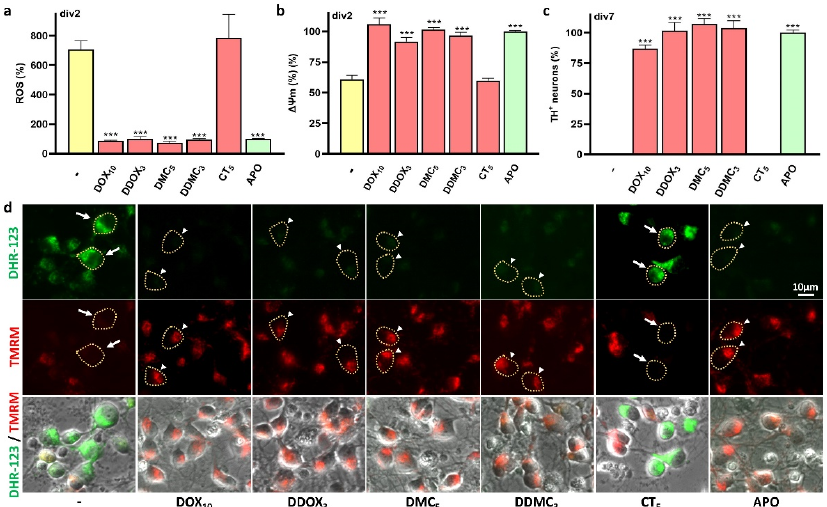
Figure 7. DOX , DDOX , DMC, and DDMC limit oxidative stress and preserve mitochondrial mem- brane potential ( ΔΨ m). ( a , b ) ROS production and changes in ΔΨ m monitored with the fluorogenic probes DHR-123 and TMRM, respectively, in div2 midbrain neurons exposed or not exposed to DOX (10 µM), DDOX (3 µM), DMC (5 µM), DDMC (3 µM), or CT (5 µM). APO (100 µg/mL) was used as a reference neuroprotective treatment. Data expressed in % of APO-treated cultures are means ± SEM (4–12). *** p < 0.001 vs. NT. One-way ANOVA followed by Dunnett’s test. ( c ) Survival- promoting effects of treatments described in ( a , b ). Data expressed in % of APO-treated cultures are means ± SEM (4–16). *** p < 0.001 vs. NT. One-way ANOVA followed by Dunnett’s test. ( d ) Images showing DHR-123 (upper panel) and TMRM (mid panel) fluorescent signals in div2 midbrain cul- tures treated or not treated with DOX , DDOX , DMC , DDMC, or CT . The lower panel represents Phaco images merged with the DHR-123 and TMRM fluorescent signals. White arrows point to neurons showing a decrease in ΔΨ m with an increase in ROS production. White arrowheads indi- cate neurons, in which ΔΨ m is preserved and ROS production contained. Yellow dotted lines rep- resent virtual boundaries of neuronal cell bodies indicated by white arrows or white arrowheads.